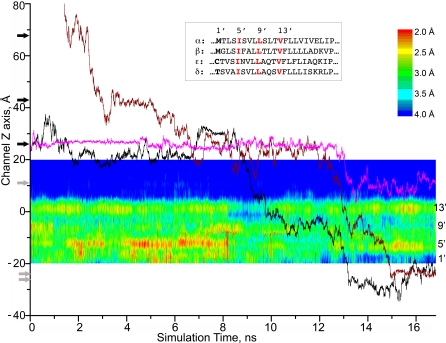
Positions of Three Cations along the Channel Axis from a Simulation with a Trans-Membrane Potential of −200 mV Superimposed upon a Color-Encoded Plot of the Effective Pore Radius, as in Figure 2
The Z-axis position of the lipid membrane spans from −20 to 20 Å. Gray arrows indicate previously described extracellular and intracellular rings of charged residues [1], while the black arrows indicate three additional rings of charge coinciding with prolonged dwell times of the cations.